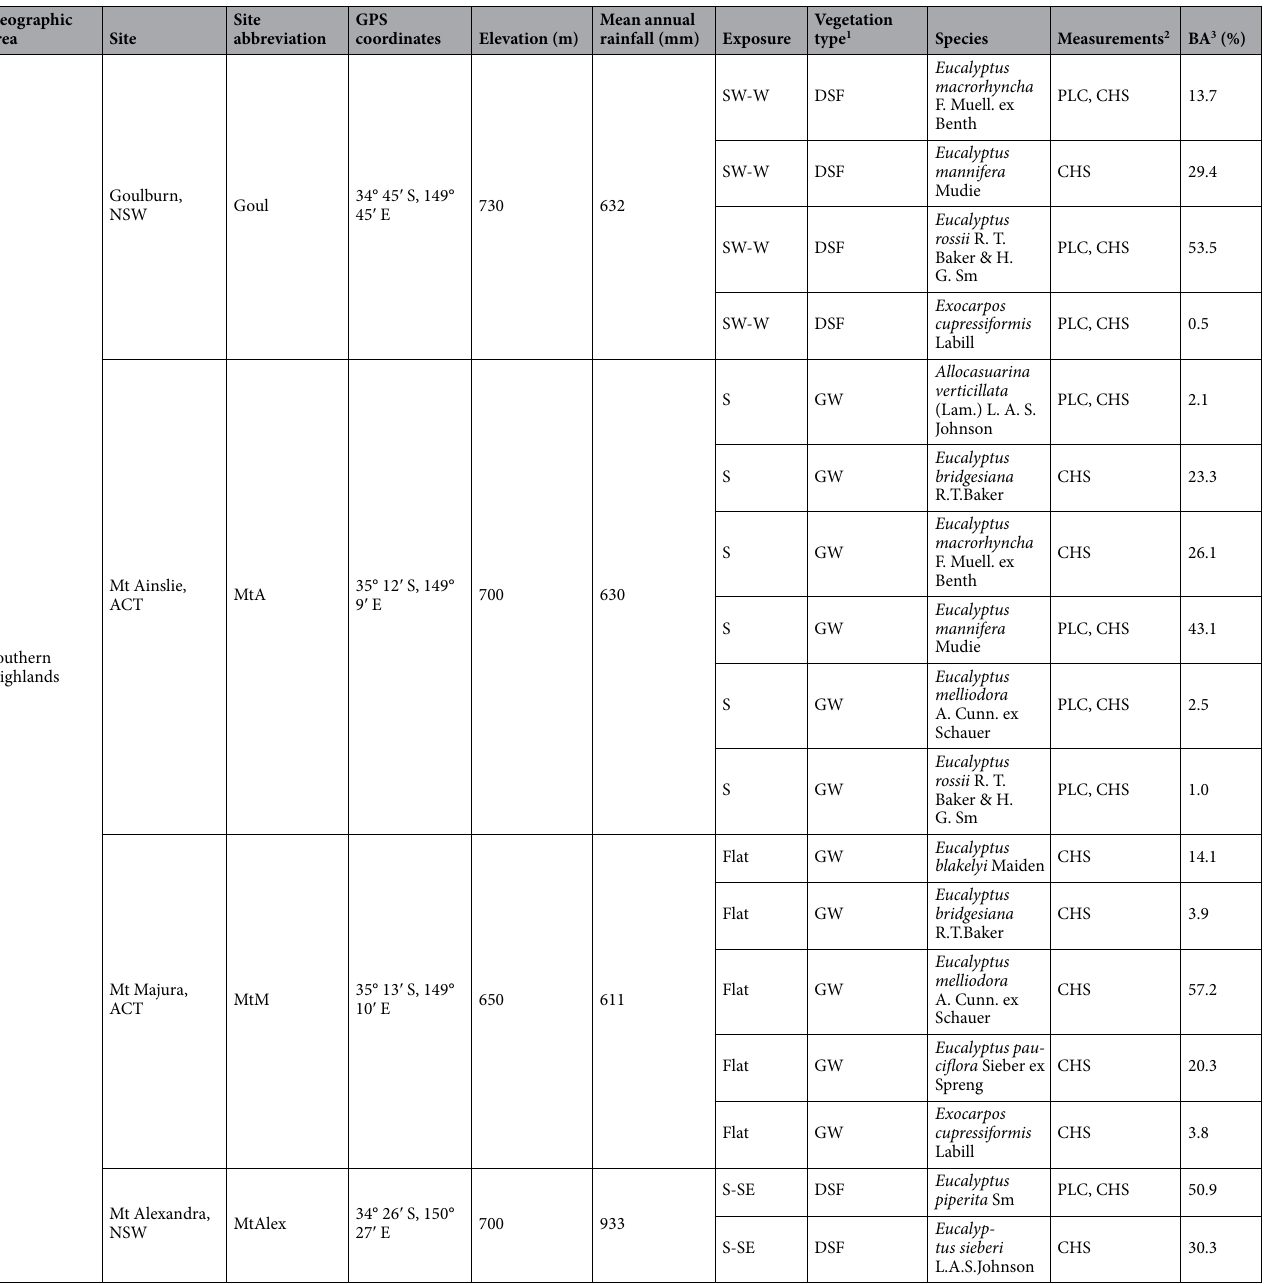
Table 1. General information of sampling sites (with abbreviations used throughout the manuscript), species measured at each site and their characteristics (exposure, GPS coordinates, elevation, mean annual rainfall, vegetation type and basal area). A list of measurements performed for each species/site is also given. 1 GW, DSW and DSF corresponds to the vegetations types Grassy Woodlands, Dry Sclerophyll Woodlands, and Dry Sclerophyll Forests, respectively. 2 PLC and CHS are percentage loss of conductivity and canopy health score, respectively. 3 BA is the contribution in basal area (%) of each species at each